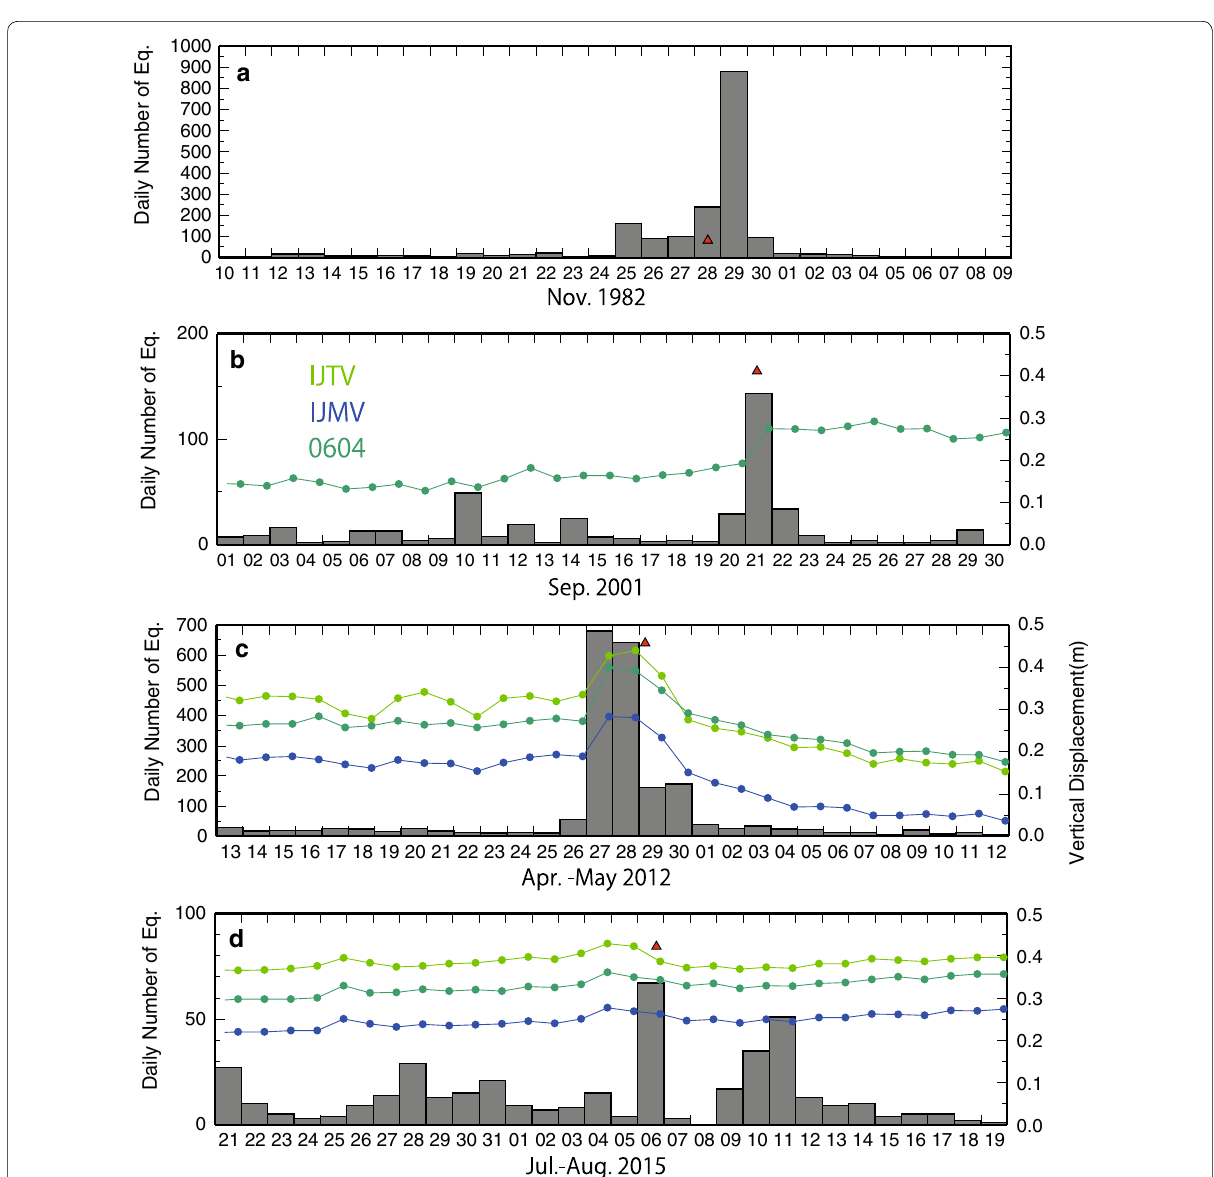
Fig. 4 The daily number of earthquakes and vertical movement at Motoyama before and after phreatic eruptions accompanied by precursors. a The eruption on November, 28–29, 1982; b the eruption on September 21, 2001; c the eruption on April 29, 2012; d the eruption on August 6, 2015. The green and blue curves denote vertical movement at GNSS observation stations. The red triangles denote the occurrence times of the eruptions, but the occurrence time of the eruption on November, 28–29, 1982 is not